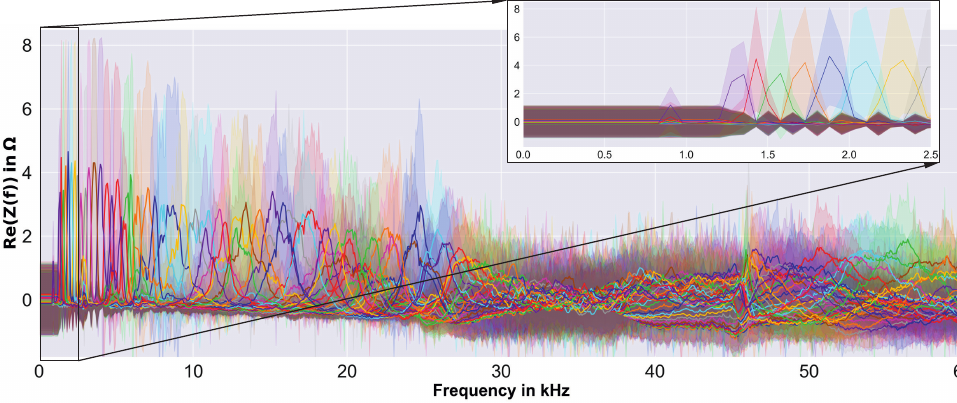
Figure 10. Summary of raw synthetic EMI spectra, scaled to have zero mean and unit standard deviation, for better clarity. The centerline is the mean value, and the surrounding translucent range represents the standard deviation per frequency of all spectra with the same damage size (approximately 1000